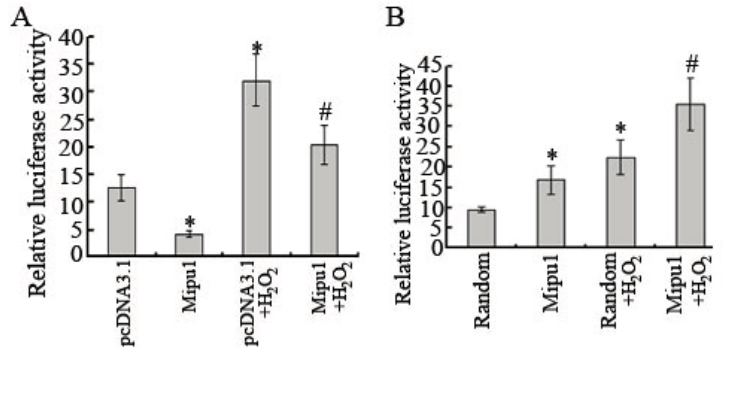
Figure 8. Effect of Mipu1 on transcription activity of the Fas promoter in H9c2 myogenic cells. ( A ) H9c2 myogenic cells were co-transfected transiently with an expression plasmid of full length Mipu1 and the reporter driven by the Fas promoter; ( B ) H9c2 myogenic cells were co-transfected transiently with RNAi plasmid of Mipu1 and the reporter driven by the Fas promoter. pcDNA3.1: the vector control group; Mipu1: Mipu1 over-expression group. *, Statistically significant vs. the vector control group (pcDNA3.1 or Random), p < 0.05; #, Statistically significant vs. the vector control + H 2 O 2 group (pcDNA3.1 + H 2 O 2 or Random + H 2 O 2 ), n =